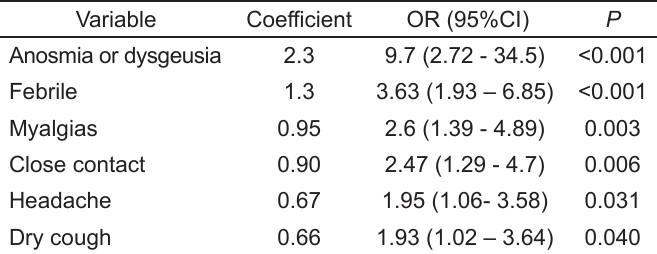
Table 3. Final prediction model.